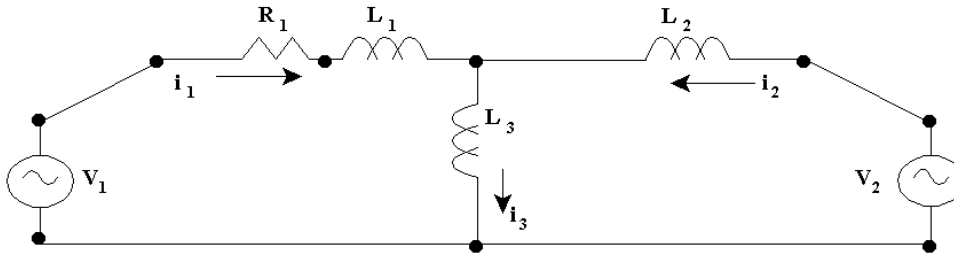
Figure A1. Single-phase equivalent system.